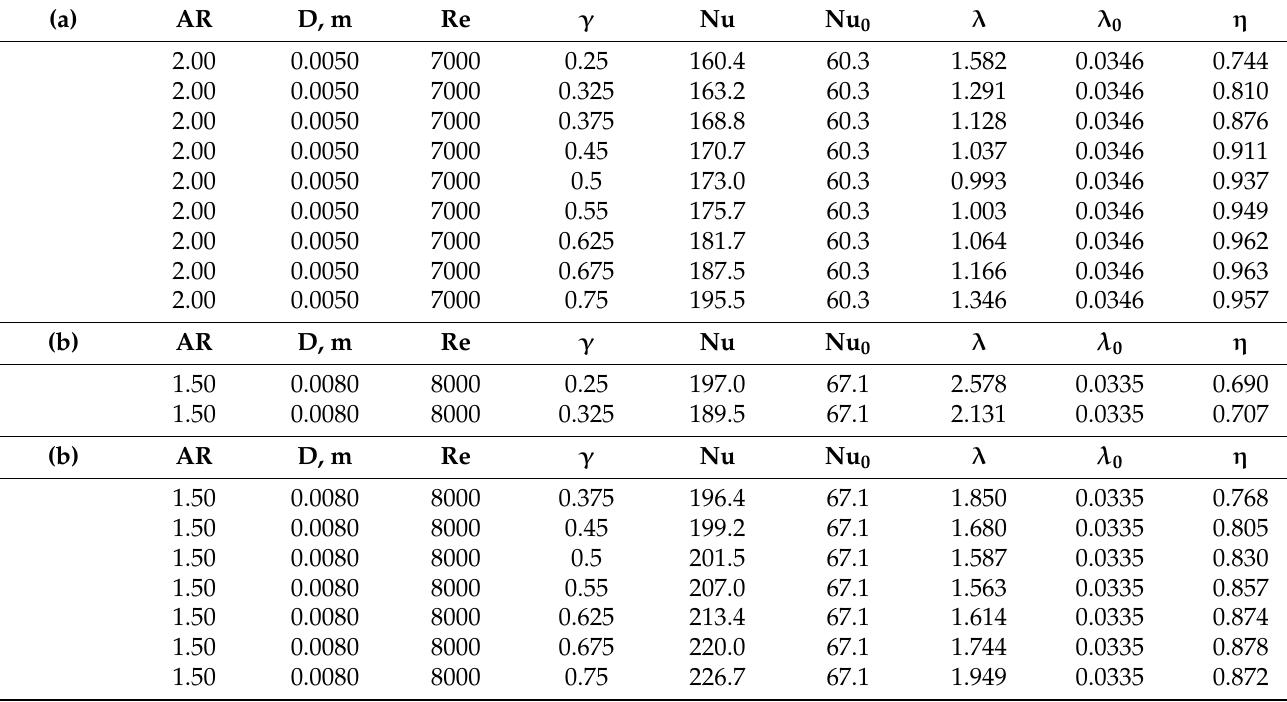
Table A3. Data of two Design points changing the centro-symmetric: (a) Ar = 2.0, Re = 7000; (b) Ar = 1.5, Re =